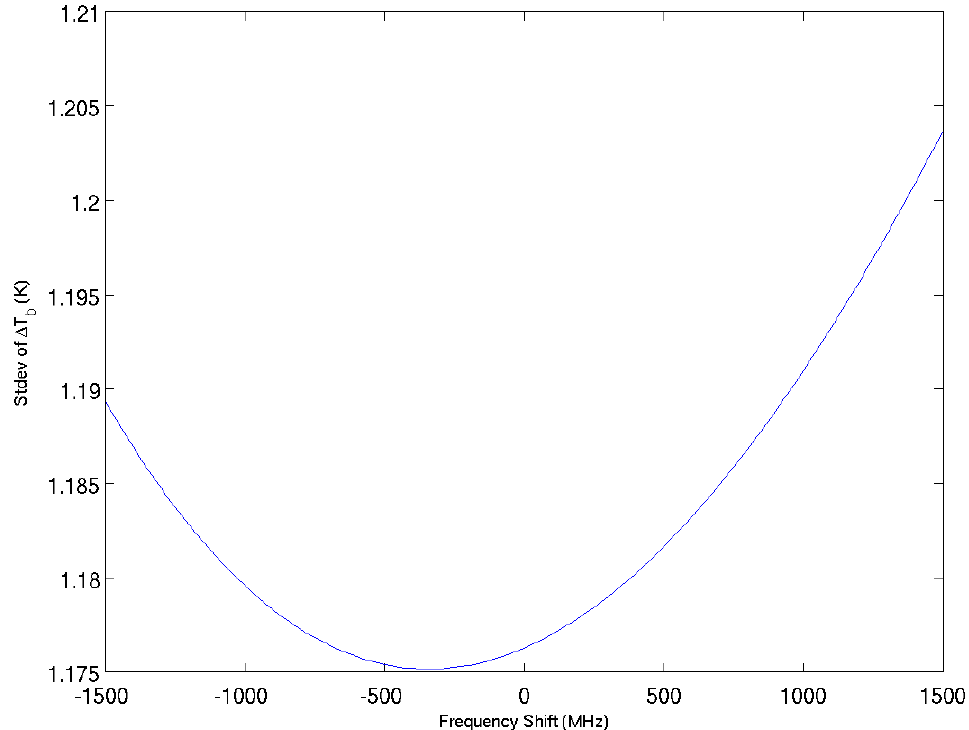
Figure 8. Amplitude of the standard deviation of ΔTb′ (Equation (10)) using SNO pairs over the tropical ocean versus the 89 GHz channel of NOAA-15 frequency shift, df .